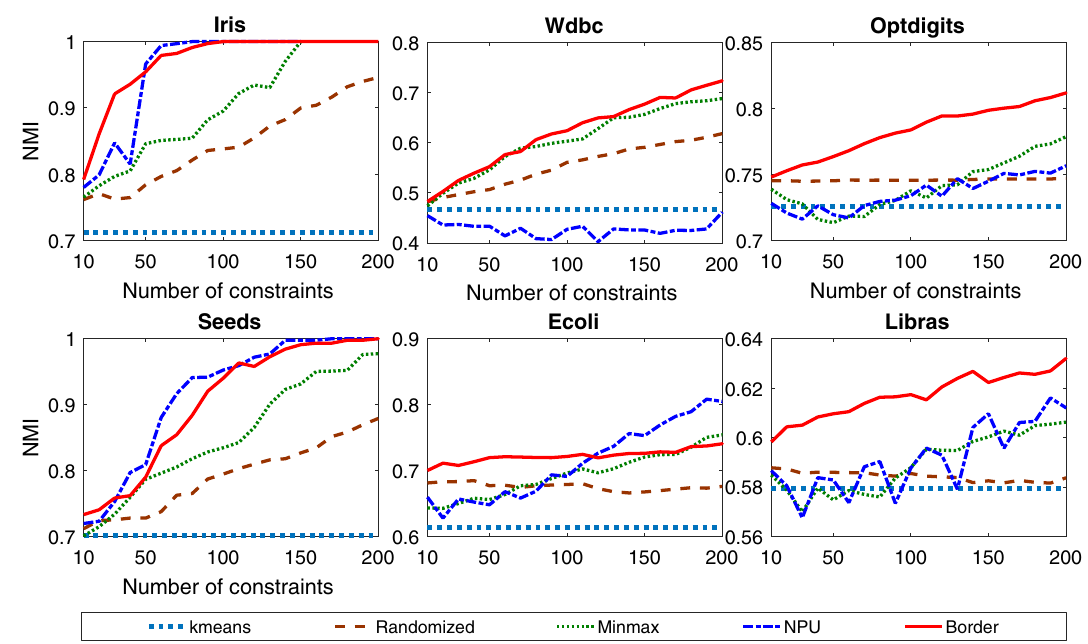
Fig. 8 Comparison among different active learning techniques